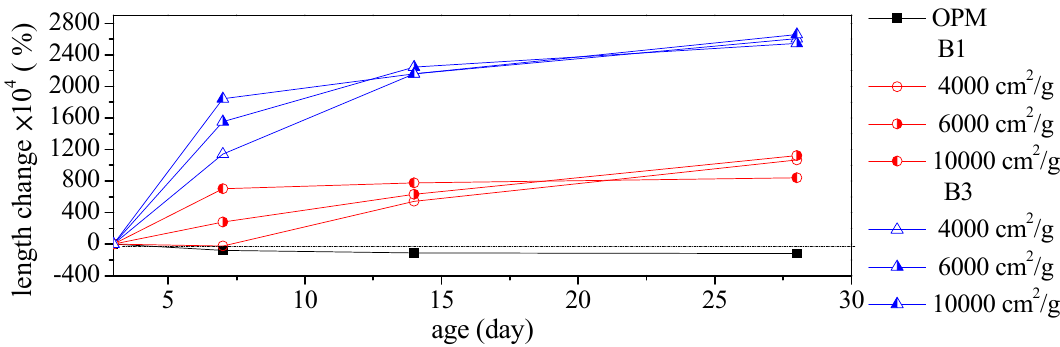
Figure 11. Shrinkage trends in samples with various quantities of BOFS and various specific surface areas.